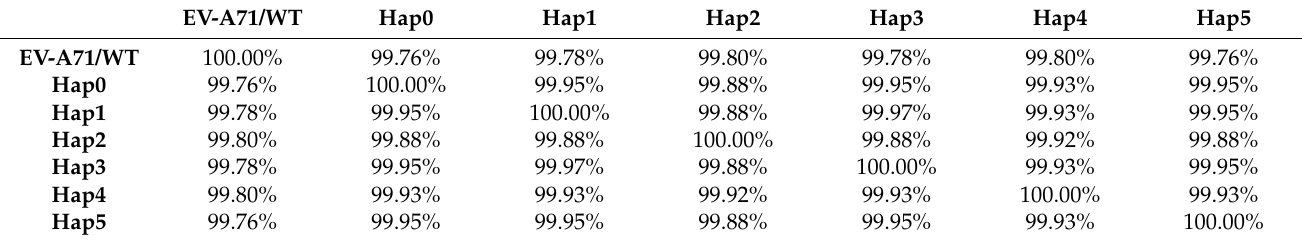
Table 1. Similarity nucleotide sequences of EV-A71/WT and the six